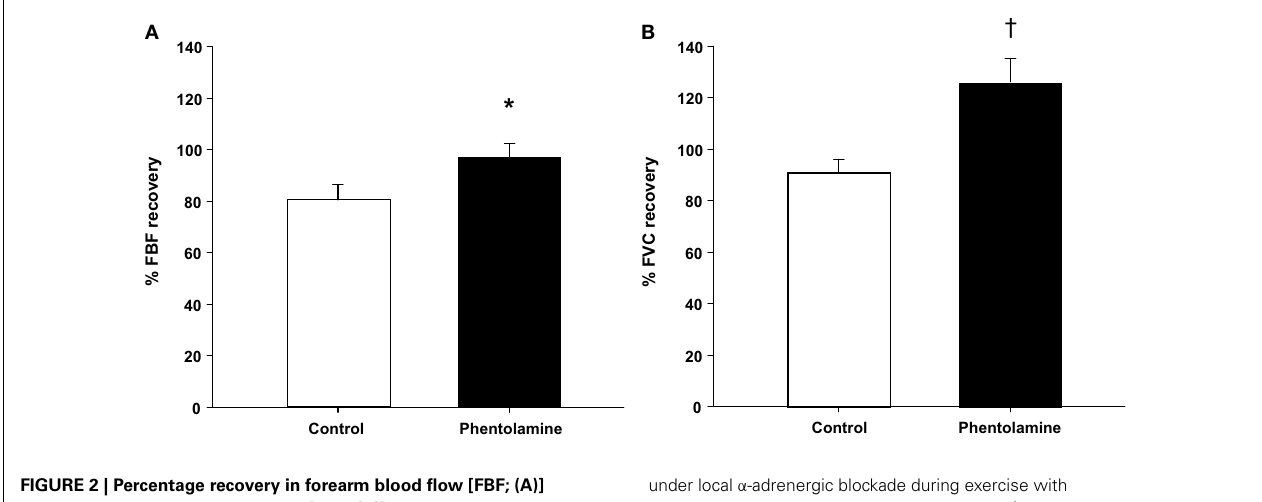
FIGURE 2 | Percentage recovery in forearm blood flow [FBF; (A)] and forearm vascular conductance [FVC; (B)] during balloon inflation. The percentage recovery in FBF and FVC was enhanced